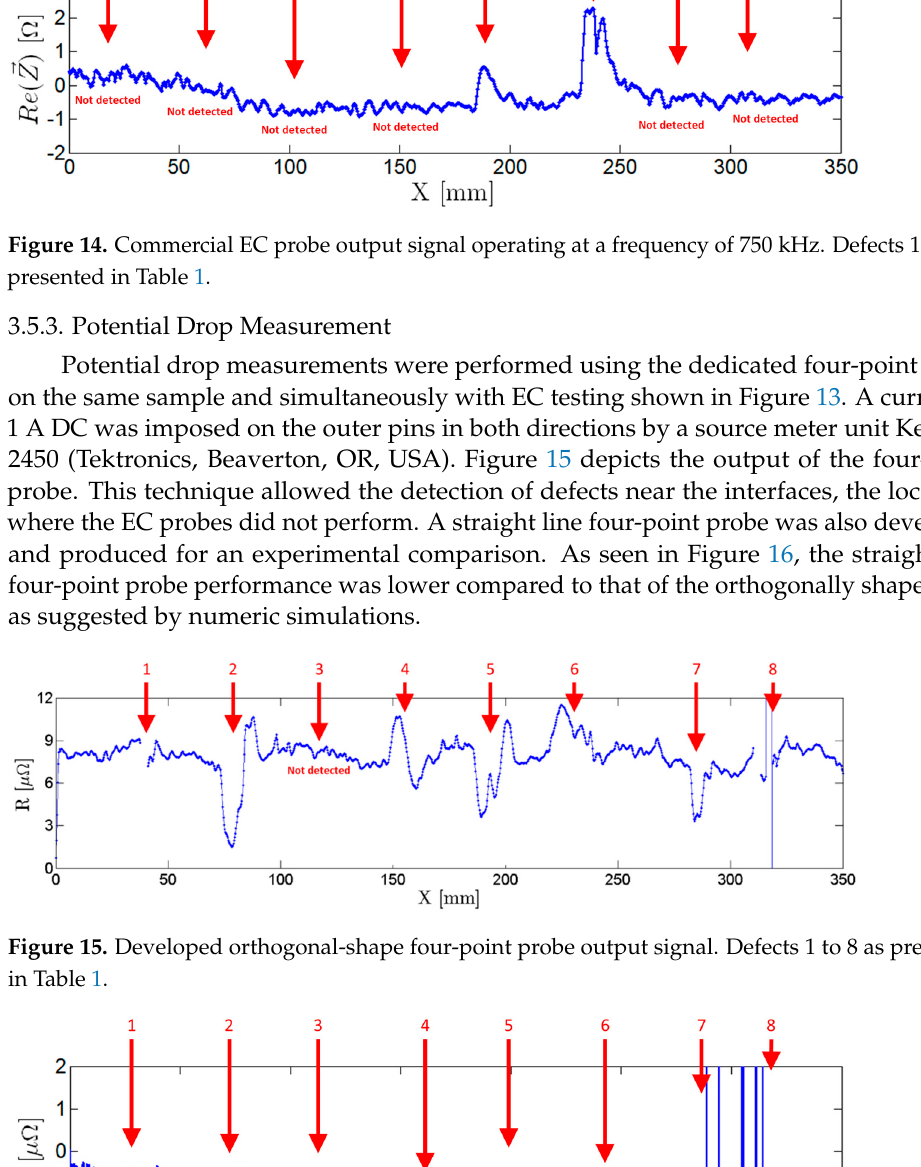
Figure 13. Customized EC probe output signal operating at a frequency of 750 kHz. Defects 1 to 8, as presented in Table 1.